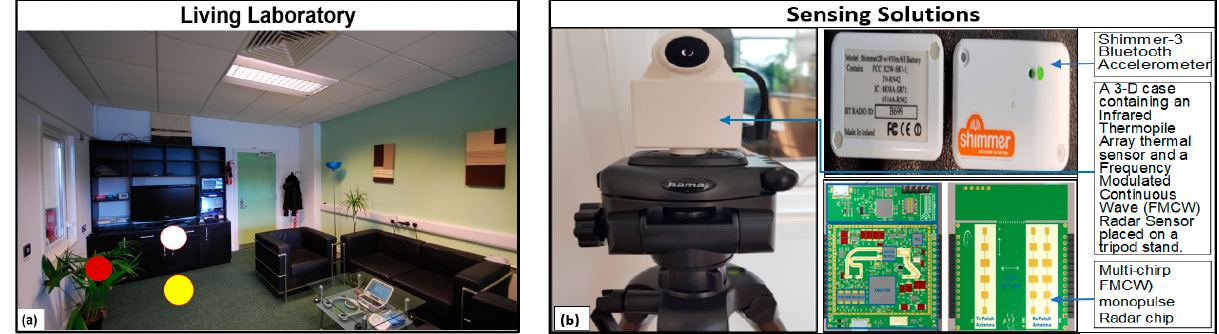
Figure 1. Sprained Ankle Rehabilitation Exercise setting: ( a ) the Living Lab where the study was conducted, and ( b ) the Sensing Solutions (SSs) used during the study. In Figure 1a, the red, white, and yellow spots indicted the locations of the side-facing SSs, the front-facing SSs, and the participants, respectively, during the study.